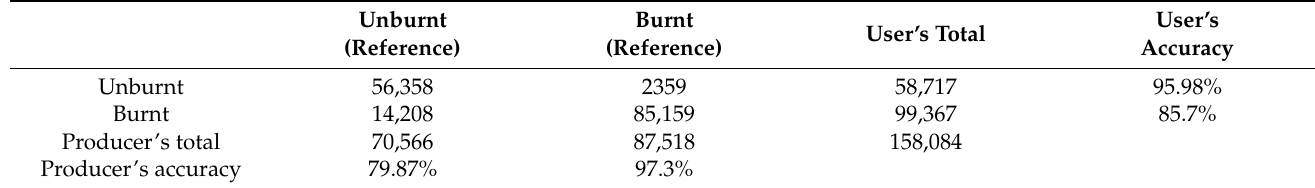
Table 7. Validation results for all years.